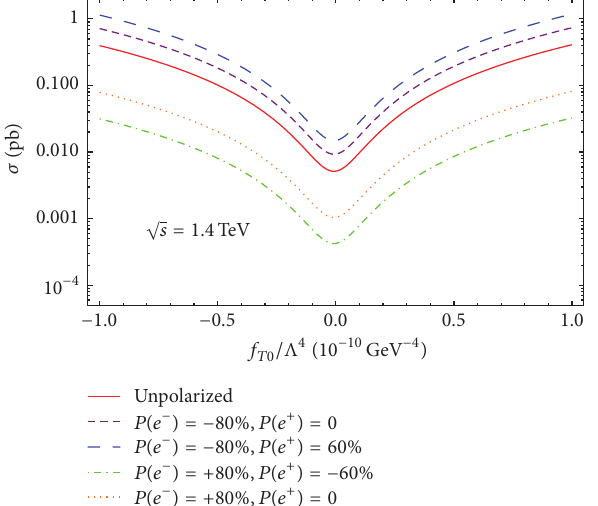
Figure 6: The total cross section for 𝑒 + 𝑒 − → ] 𝑒 𝑊 − 𝑊 + ] 𝑒 processes as a function of 𝑓 𝑇0 /Λ 4 at the √𝑠 = 1.4 TeV for different polarization of the positron and electron beams.